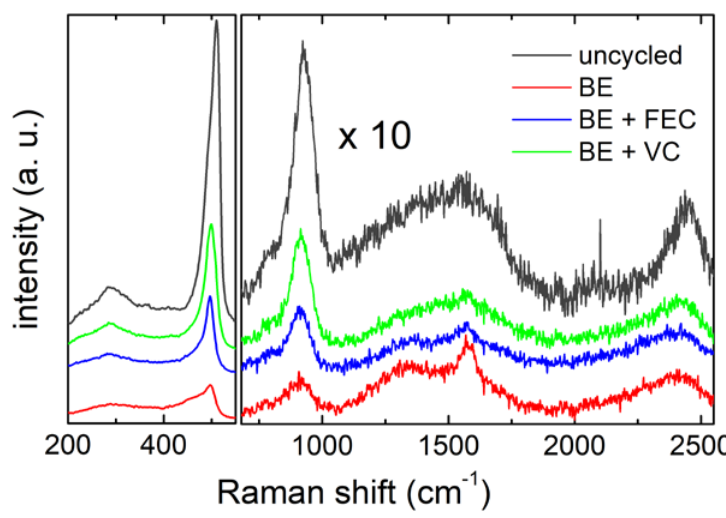
Figure 3. Raman spectra of the Si NW electrodes, before and after 5 cycles in the 3electrolytes. Spectra in the region between 720 cm −1 and 2550 cm −1 have been magnified by a scaling factor of 10.